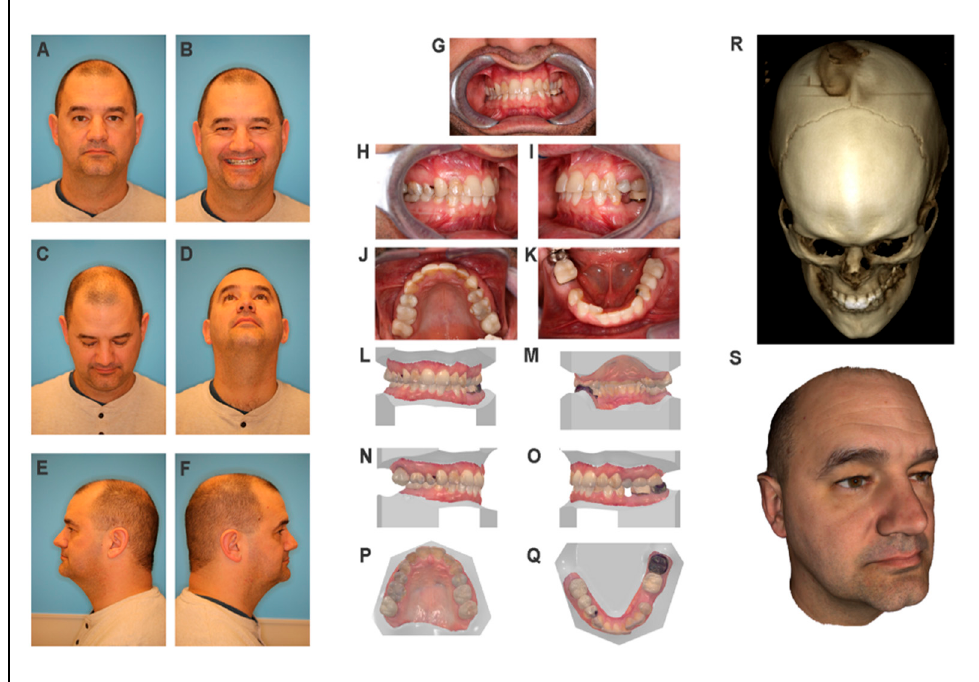
Figure 3. Clinical assessment of the unaffected father of the proband. ( A – F ). Two-dimensional photographs of the proband’s father. ( G – K ) Intraoral photographs (oral photo is flipped). ( L – Q ) Intraoral scan images. ( R ) Three-dimensional CBCT scan image. ( S ) Three-dimensional soft tissue image.